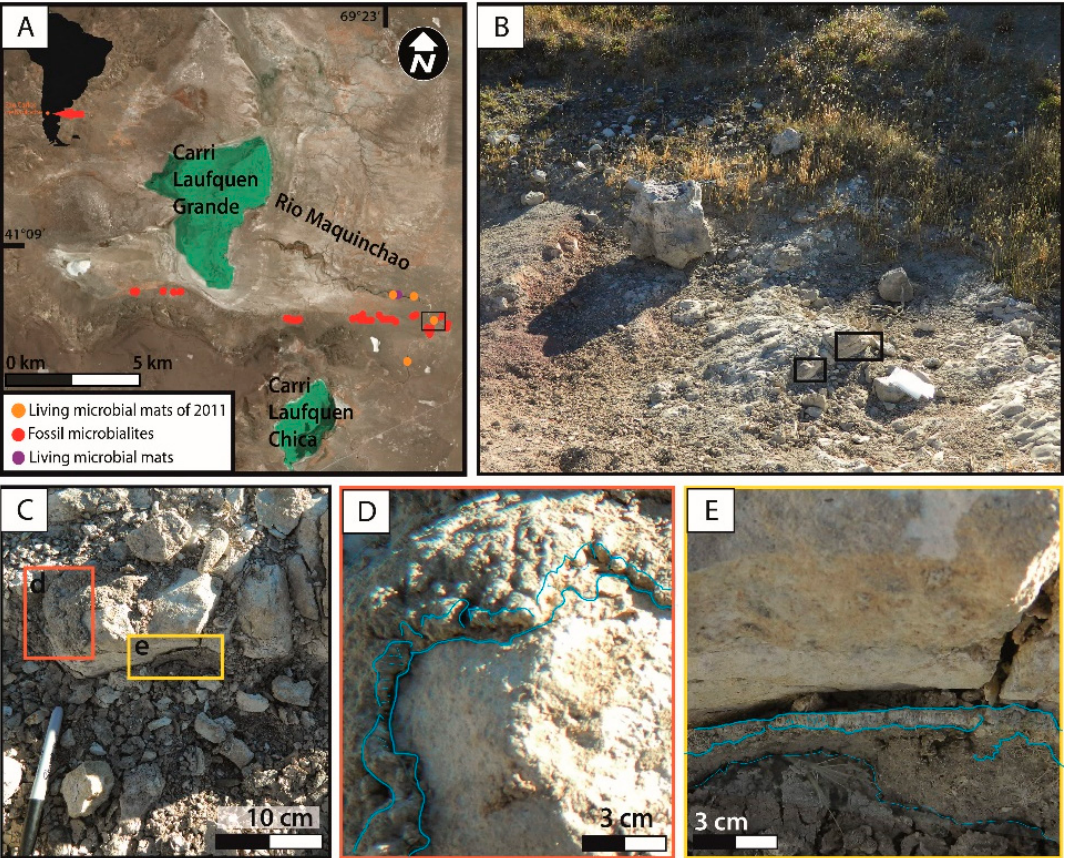
Figure 1. Sampling area. ( A ) Map of Maquinchao Basin with the location of living microbial mats in 2011 and 2016, fossil microbialites and sampling location of modern microbial crusts (black square). ( B ) Enlargement of black square in ( A ). Black rectangles enclose crusts on hard substrate. ( C ) Enlargement of area shown in ( B ), highlighting the crusts on the top and lateral side of the hard substrate. ( D ) Enlargement of the orange rectangle in ( C ), showing the pustular-like crust on the hard substrate. ( E ) Enlargement of the yellow rectangle in ( C ), showing the smooth crust probably attached to the rock substrate in the Figure 1C.